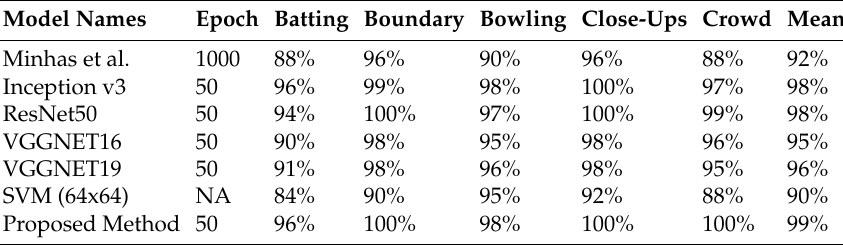
Table 6. Classification F1-score comparison with state-of-the-art models. Model